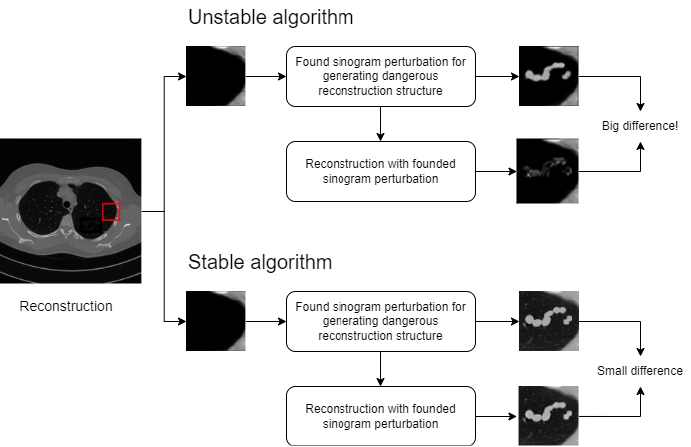
Figure 1. Demonstration of the difference between robust and not robust reconstruction